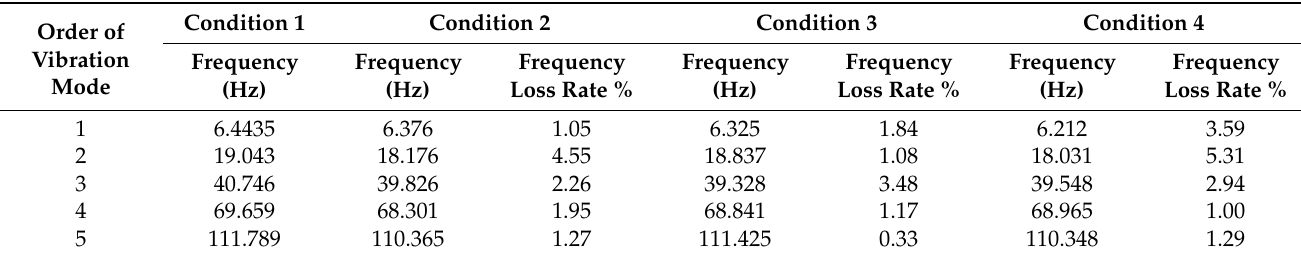
Table 3. Frequency loss rates under different damage conditions.